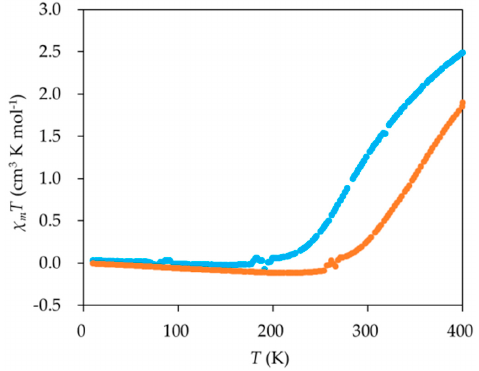
Figure 4. χ m T - T plots for 1-Cl (blue dots) and 1-Br (brown dots).